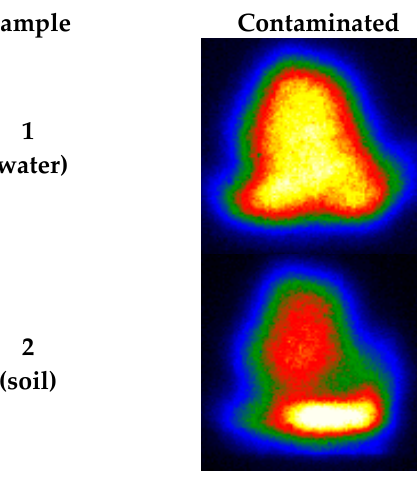
Figure 5. Plasma images correspond to different samples (first